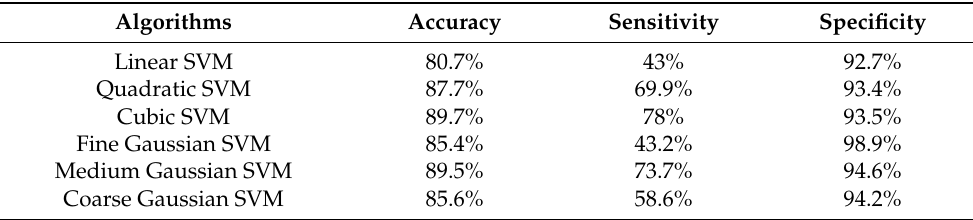
Table A5. Detailed classification performance of support vector machines (SVM) classifiers.